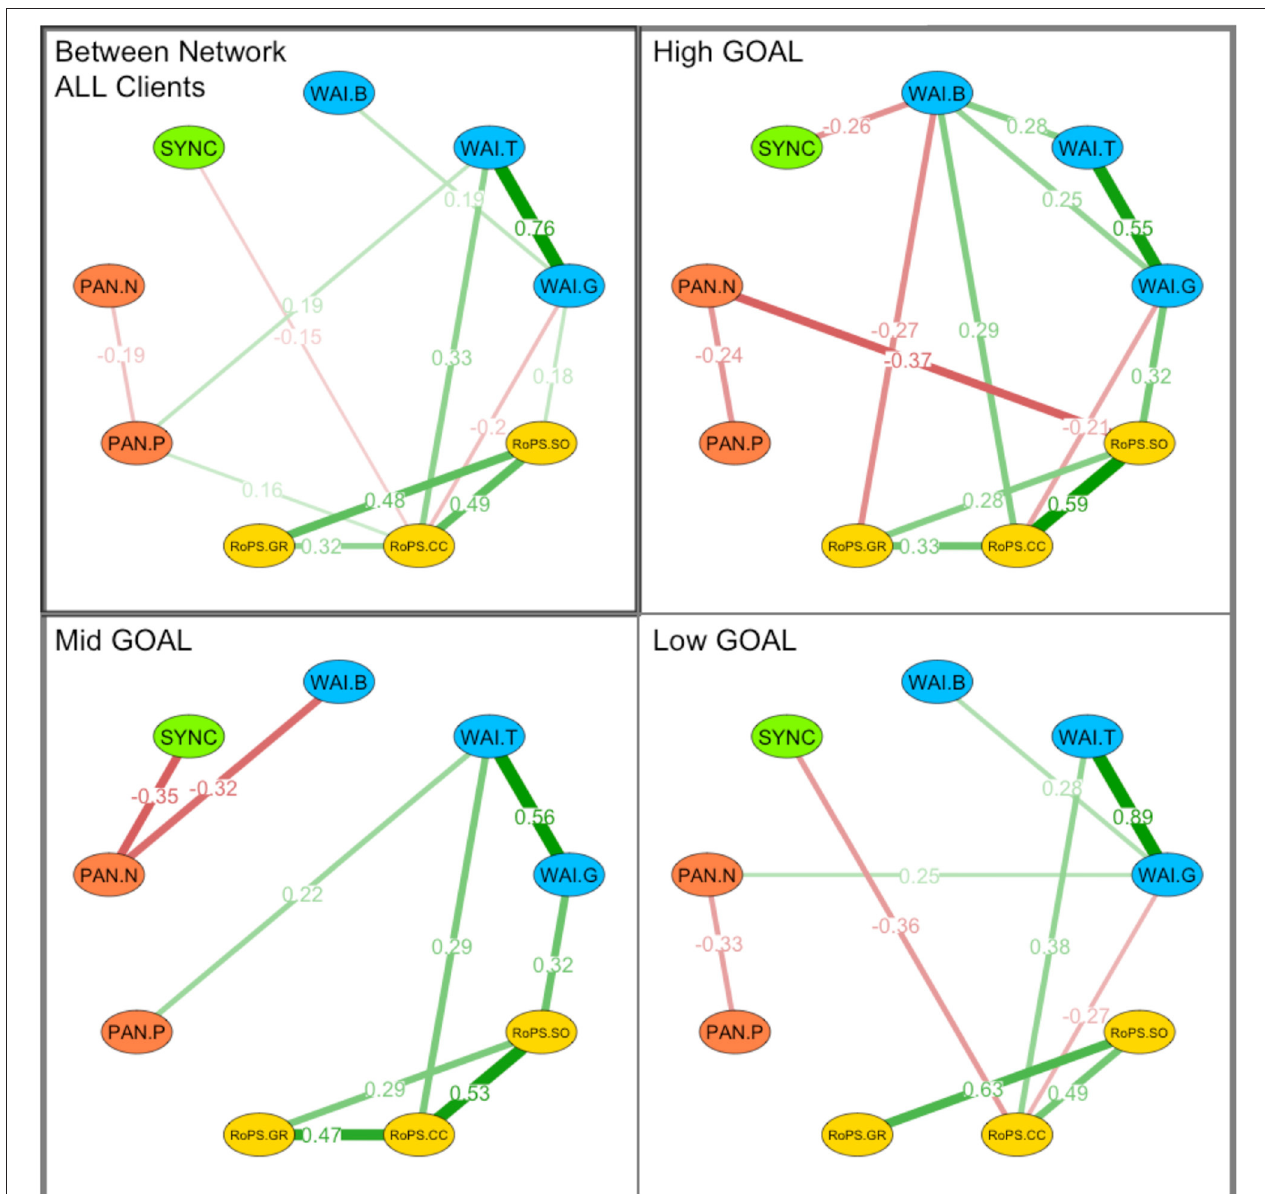
FIGURE 11 | Between network analysis by goal groups. Network analyses: Between network analysis for associations between synchrony (SYNC), working alliance (WAI), affective experience (PAN), and cognitive self-regulation (RoPS). Associations highlight nodes between the following variables: WAI.B, Working Alliance Bond; WAI.T, Working Alliance Task Setting; WAI.G, Working Alliance Goal Orientation; RoPS.SO, Result-oriented Problem and Self-Reflection.Self-Organization; RoPS.CC, Result-oriented Problem and Self-Reflection.Concrete Changes; RoPS:SO, Result-oriented Problem and Self-Reflection.Self-Organization; PAN.P, PANAS Positive Affect; PAN.N, PANAS Negative Affect; Associations are clustered by “ALL Clients” as well as groups of High GOAL attainment, Mid Goal attainment, and Low Goal attainment.